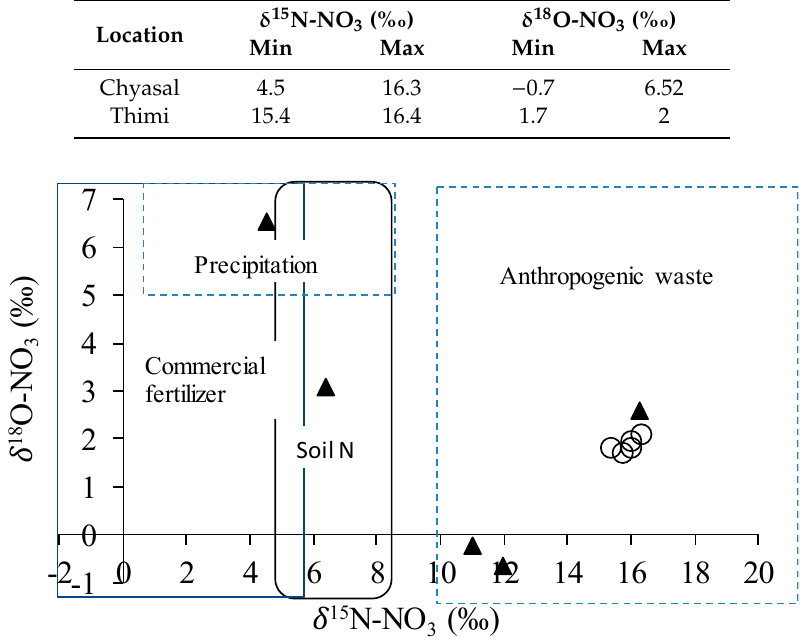
Figure 5. Stable oxygen and nitrogen isotope compositions for identifying the source and process of nitrate contamination from samples collected monthly from Chyasal (triangles) and Thimi (circles).